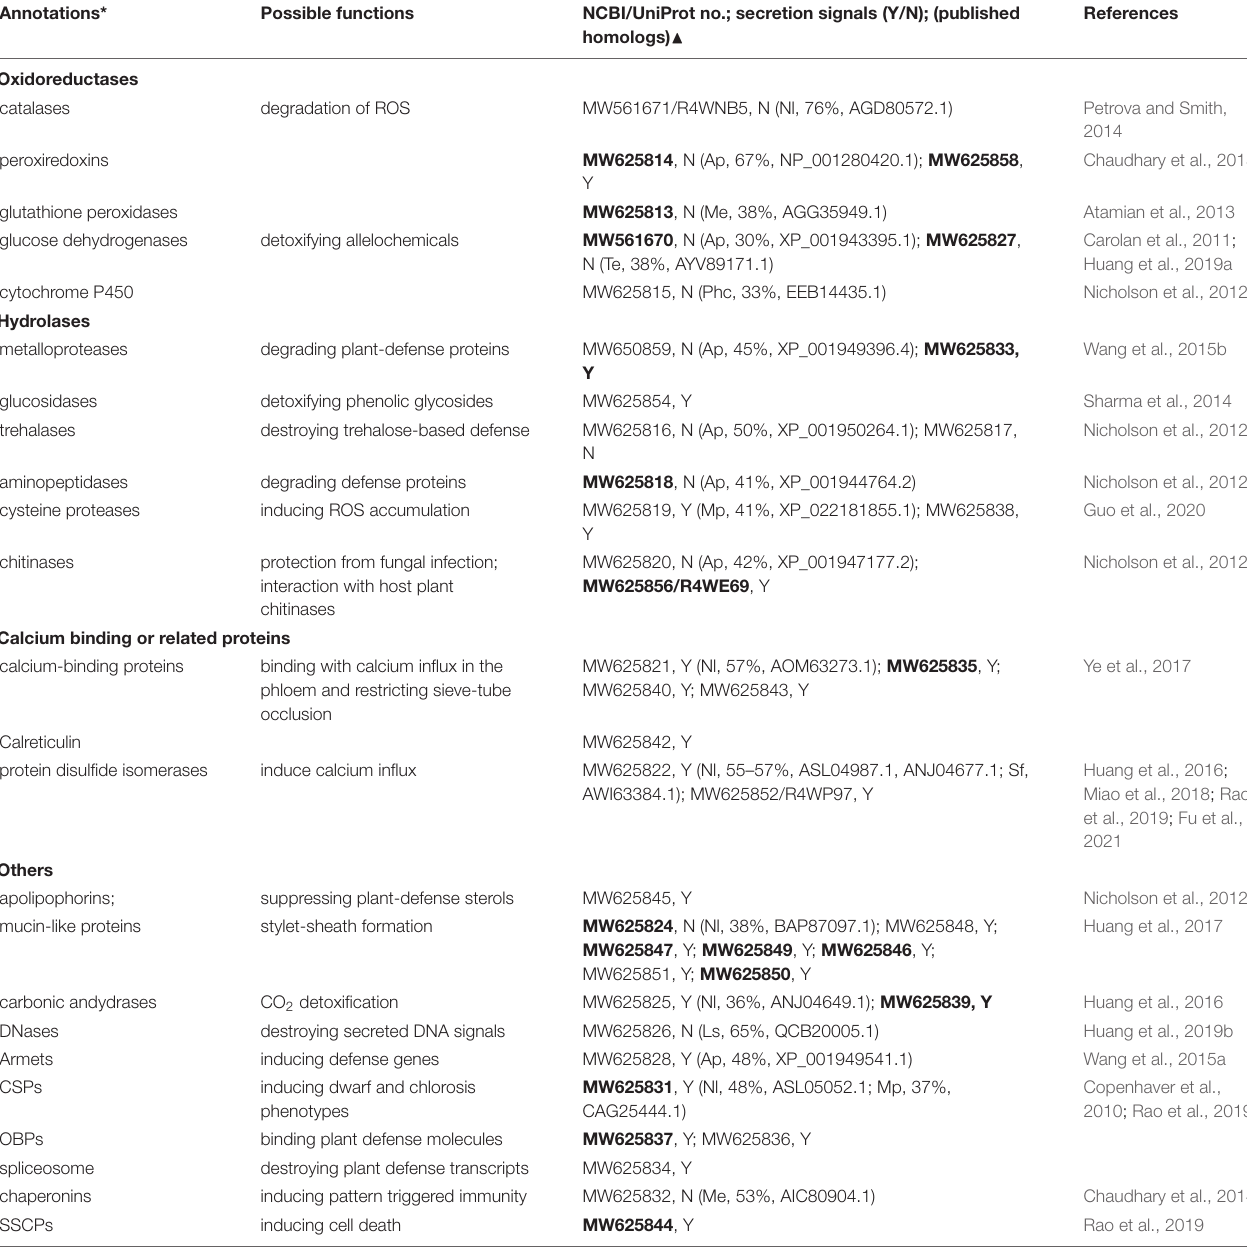
TABLE 1 | Potential effectors in the